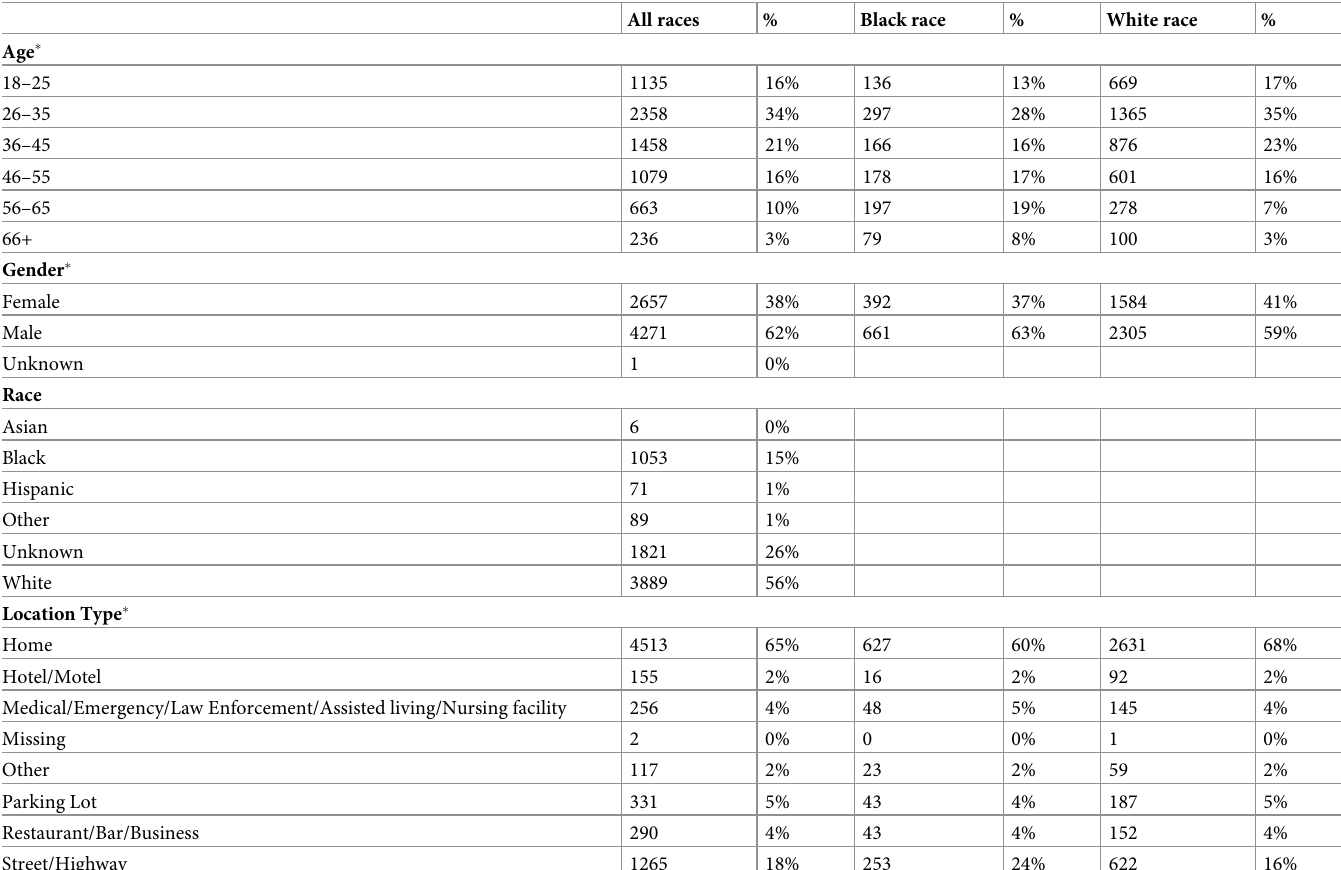
� Chi-square test between individuals of Black and White race indicated significant differences at p-values of < 0.001 for age categories and location type and p- value < 0.05 for